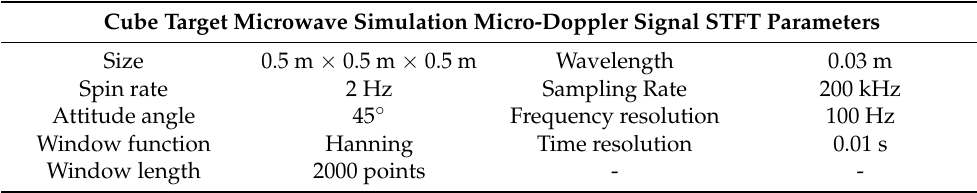
Table 1. Cube target microwave simulation micro-Doppler signal STFT